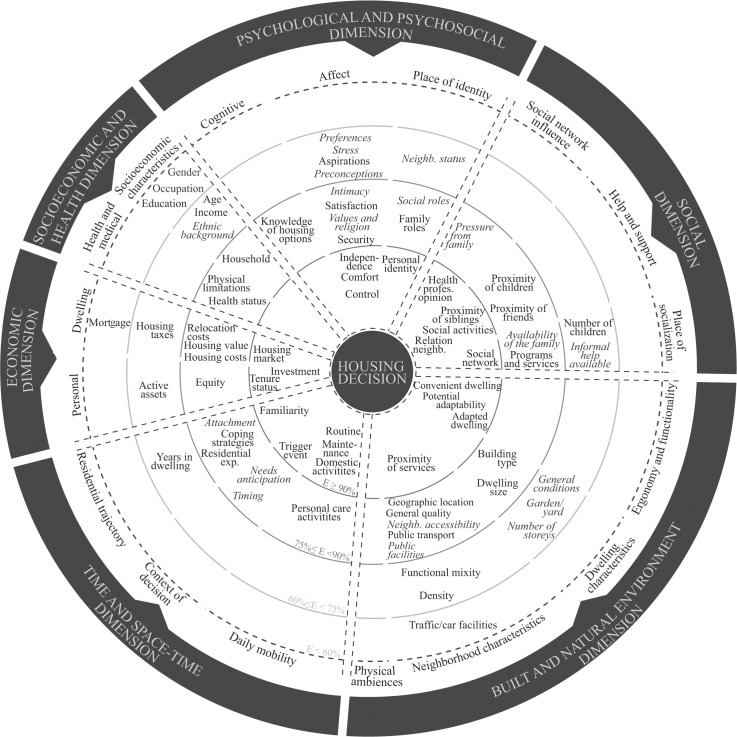
Factors influencing the housing decision of older adults, classified by the meaning and experience of home dimensions.(A) Factors are classified by their overall reported effect (E) on the housing decision of older adults. The ones closer to the center have a greater effect. (B) Italics: Factors for which a discrepancy was identified between studies with different methods.